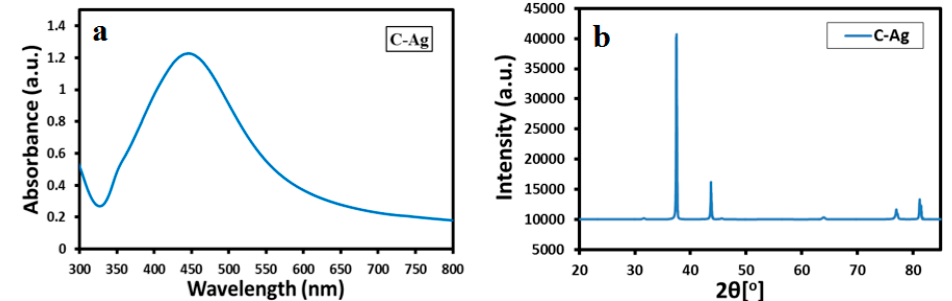
Figure 9. ( a ) UV-Vis absorption spectra; and ( b ) XRD diffractogram of chemically synthesized silver nanoparticles.